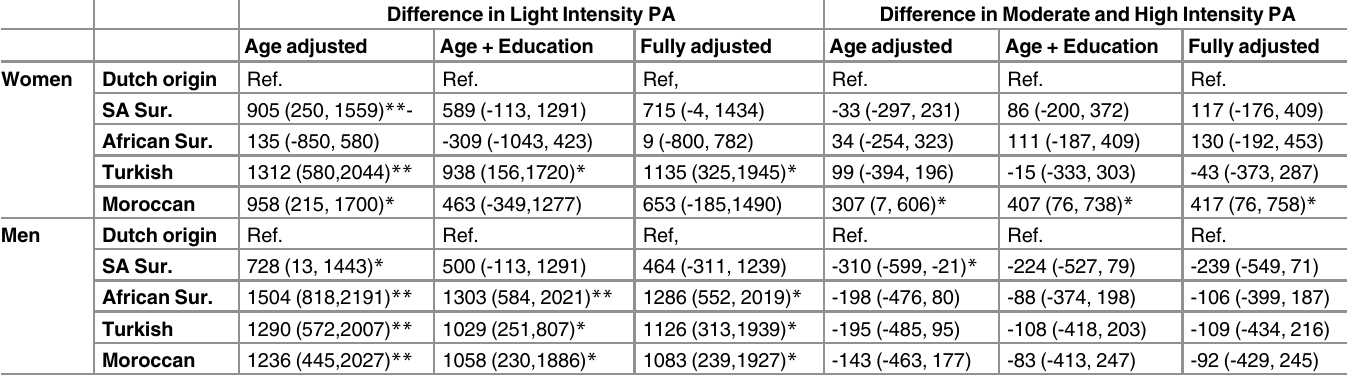
Table 4. Ethnic differences in the discrepancy between objective (Actiheart) and subjective (SQUASH questionnaire) measures of Physical Activ- ity in minutes per week.